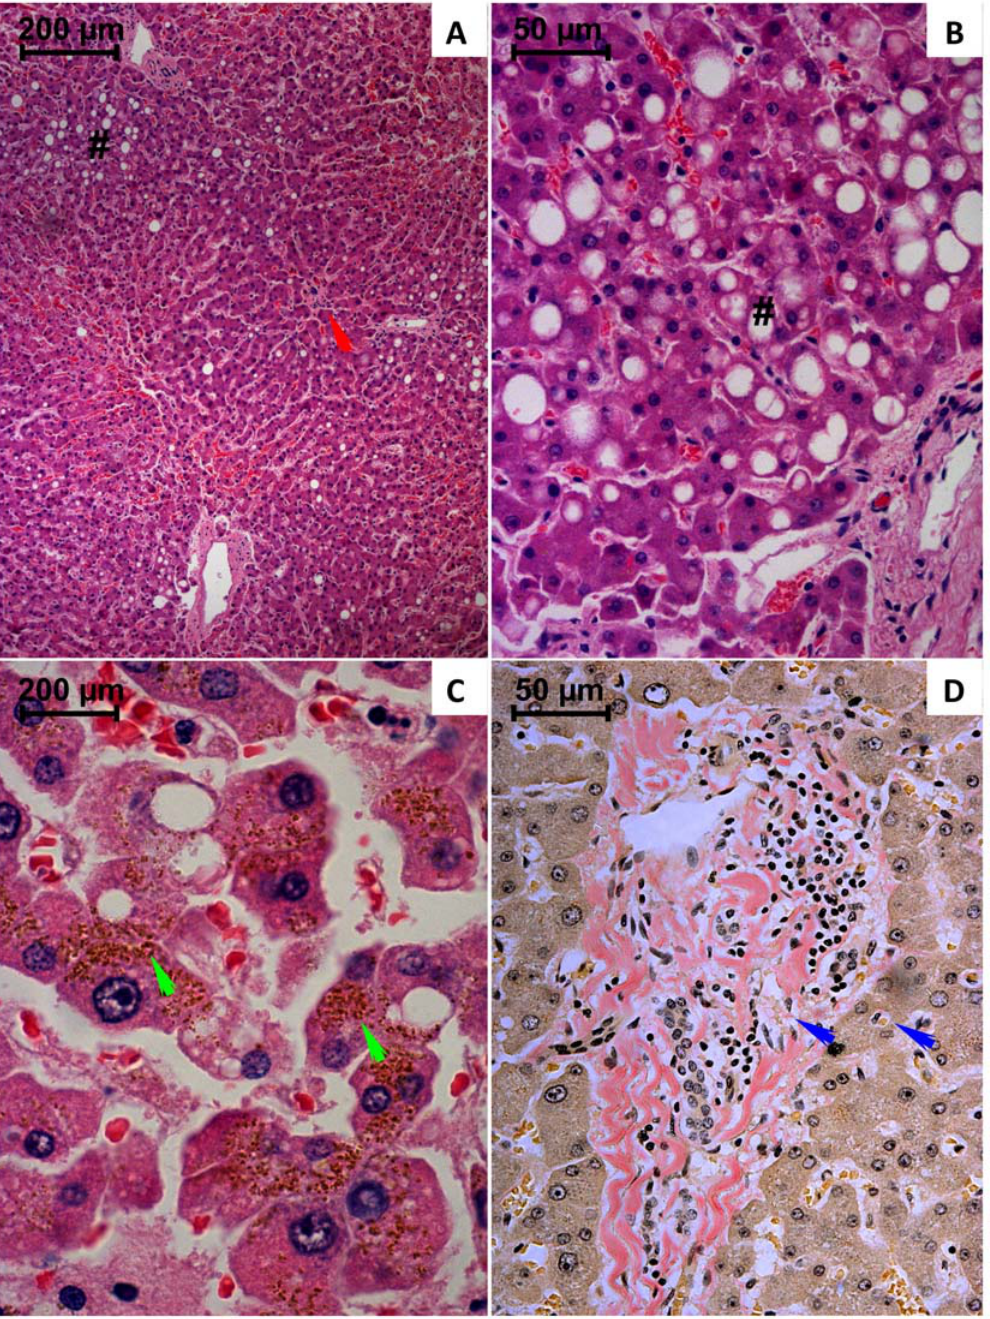
Figure 3. Light micrographs of liver from paraquat human fatal poisonings stained with hematoxylin-eosin (A–C) and van Gieson (D). In A, a marked enlargement of centrilobular sinusoids with erythrocytes trapped in the fibrinoid deposit; enlargement of large blood vessels walls with complete obstruction of a centrilobular vein (red arrow); macrovesicular vacuolization of periportal hepatocytes ( # ) it is also evident. In B, is shown macrovesicular ( # ) and microvesicular vacuolization in periportal hepatocytes. In C, it is observed near the centrilobular zone, extensive intracellular yellow-brownish deposits, cellular necrosis with numerous cell debris within enlarged sinusoidal spaces. In D, it is observed an intensive collagen deposition surrounding periportal and the sinusoidal spaces (blue arrow); it is also notorious the increase of cellular density in the periportal area, namely fibroblast-like cells and mononuclear leukocytes.